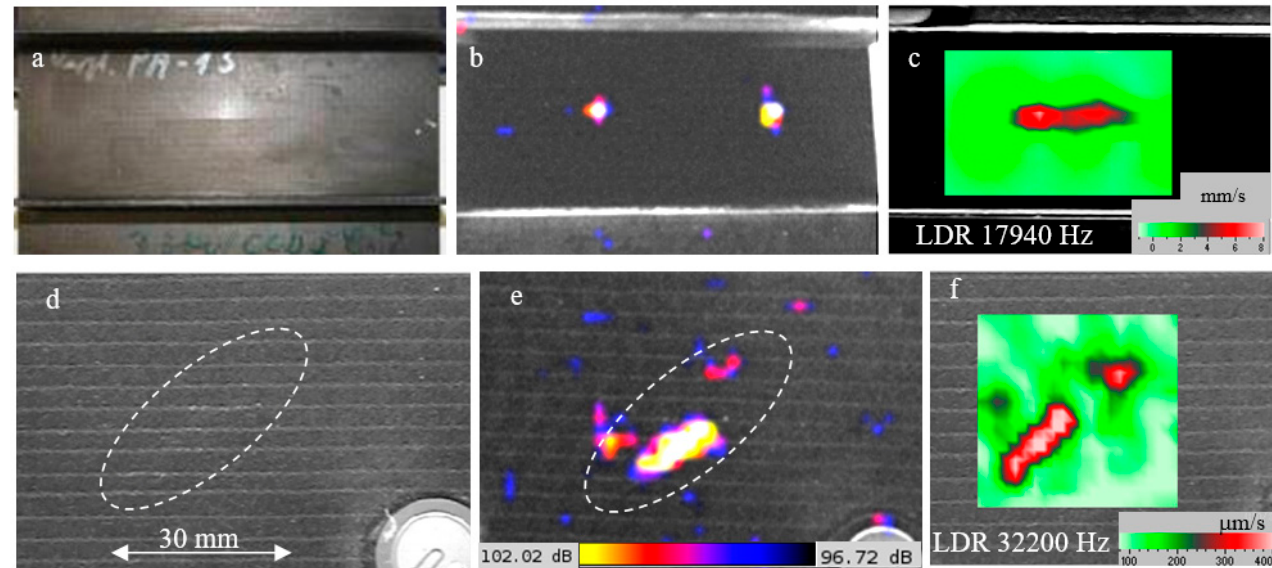
Figure 22. ( a ) crack in CFRP stringer-reinforced sample, SoundCam image ( b ), laser vibrometer LDR image ( c ); ( d ) BVID in non-crimp fabric CFRP; fractional LDR 32,200 Hz vibrometry image ( f ) and full-field AE image using acoustic camera ( e ).